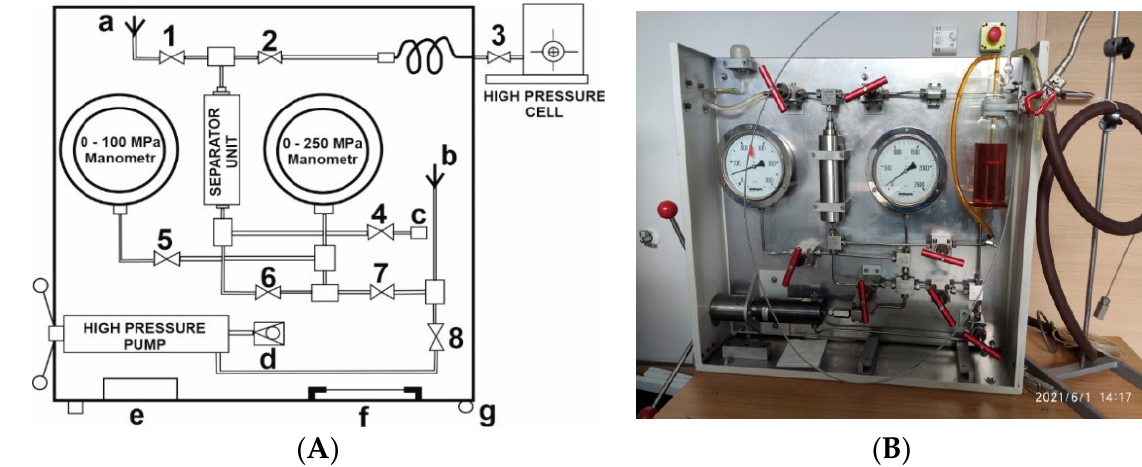
Figure 1. ( A ) Schematic diagram of transportable high-pressure unit complete with high-pressure cell. (a) Pressure medium reservoir, (b) oil reservoir, (c) to vacuum line, (d) one-way valve, (e) holder for pump handles, (f) holder for high-pressure cell, and (g) wheels for easy transportation. Numbers 1–8: high-pressure valves that enable the pressurization of particular sections of the high-pressure unit. ( B ) Picture of transportable suitcase. Reproduced from Reference [18], with the permission of AIP Publishing. tions in coordination chemistry [18].